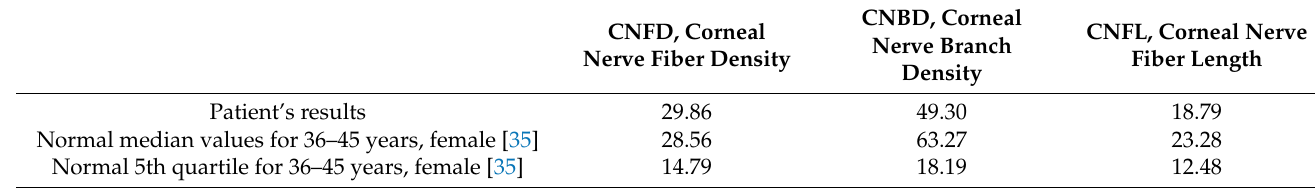
CNBD, Corneal CNFL, Corneal Nerve Nerve Branch Fiber Length Density